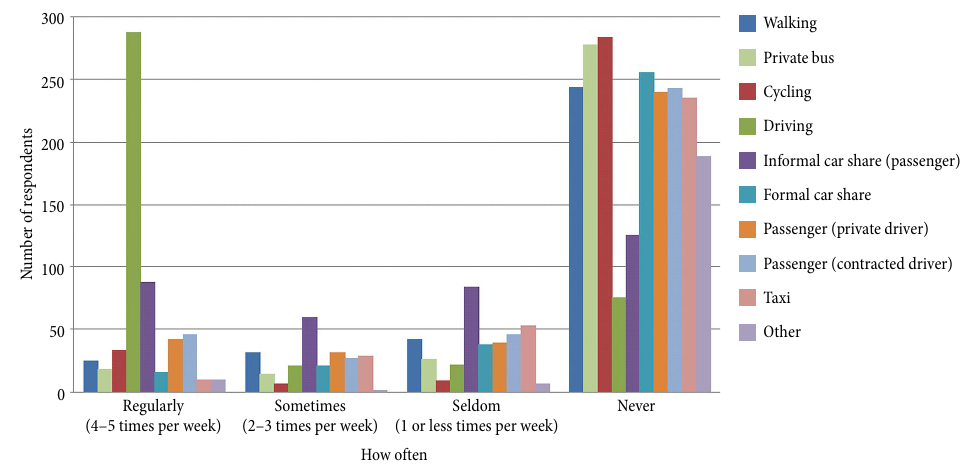
Fig. 3. Patterns of travellers and their regularity of using different modes to travel to